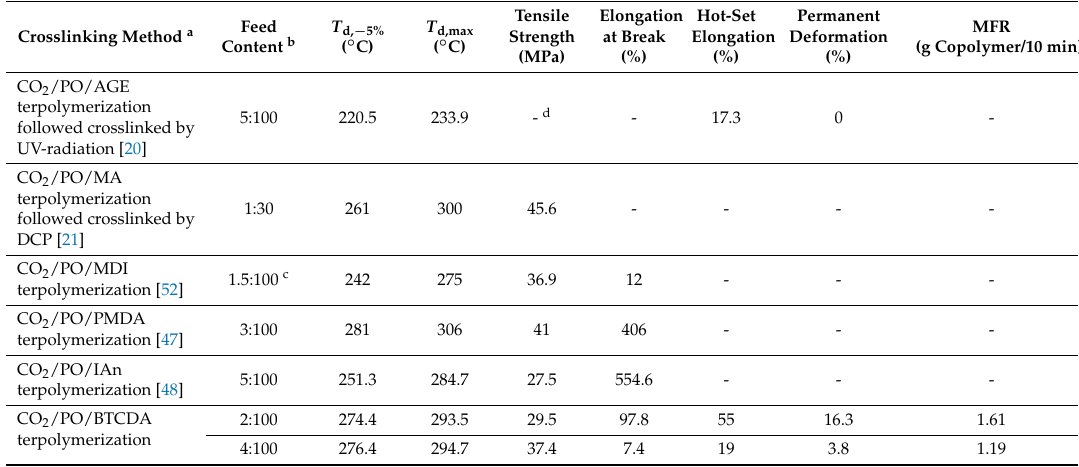
Table 5. Properties comparison of crosslinked PPCs prepared in this paper and reported by other groups.